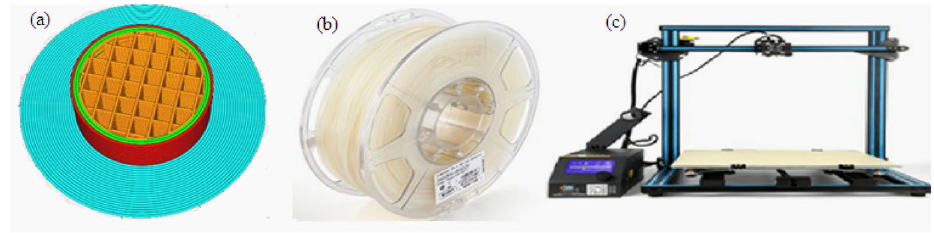
Figure 1. Machines used in 3D-printing, ( a ) horizontal cross section of the designed shape, ( b ) Esun Filaments and ( c ) 3D-printing machine model Creality